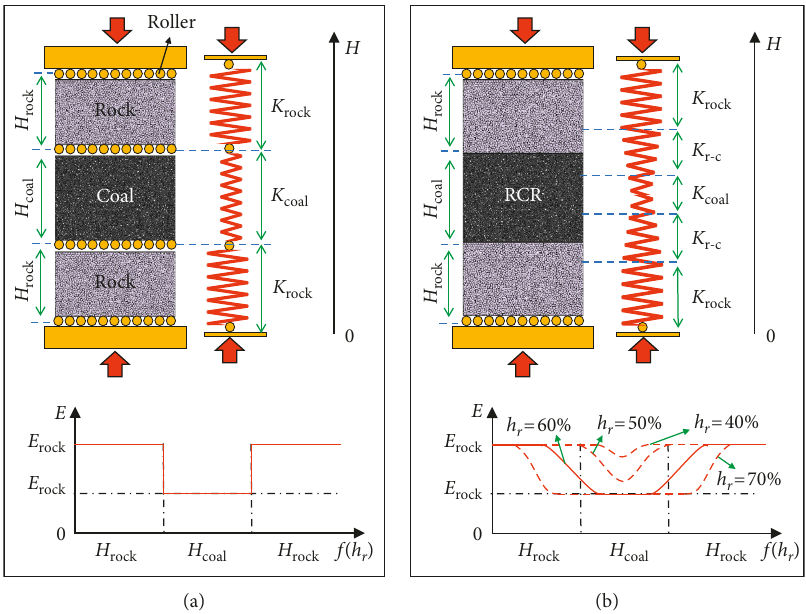
Figure 10: Mechanical models of the RCR samples. (a) Series-connected sample without rock-coal surface interaction, in which rollers are installed to reduce the friction. The lower represents the elastic modulus versus height of the series-connected sample. (b) RCR sample with rock-coal surface friction. The lower shows the elastic modulus versus height of the RCR sample. In the rock-coal interface area, the elastic modulus gradually changes from E rock to E coal